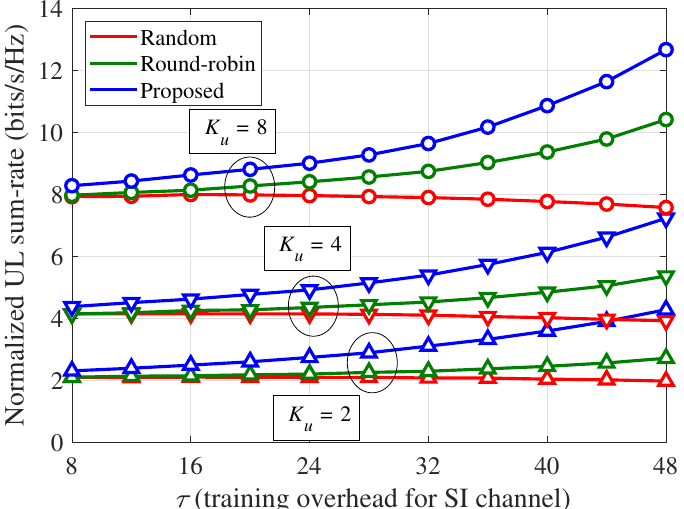
Figure 6. Normalized UL sum-rate ( η u ) per channel use according to the number of UEs ( K u ) and SI training overhead ( τ ): α = 70 dB, κ ij = 3, and 80 dB path loss between the BS and UE.